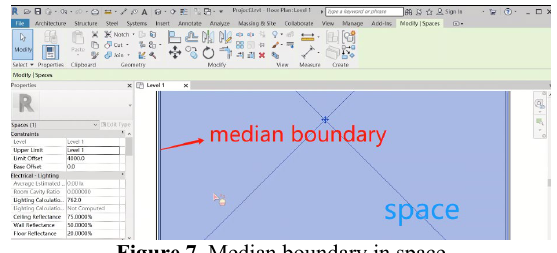
Figure 7. Median boundary in